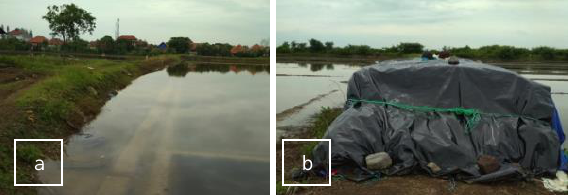
Figure 5. Flooded salt pond (a) and a salt stockpile of salt